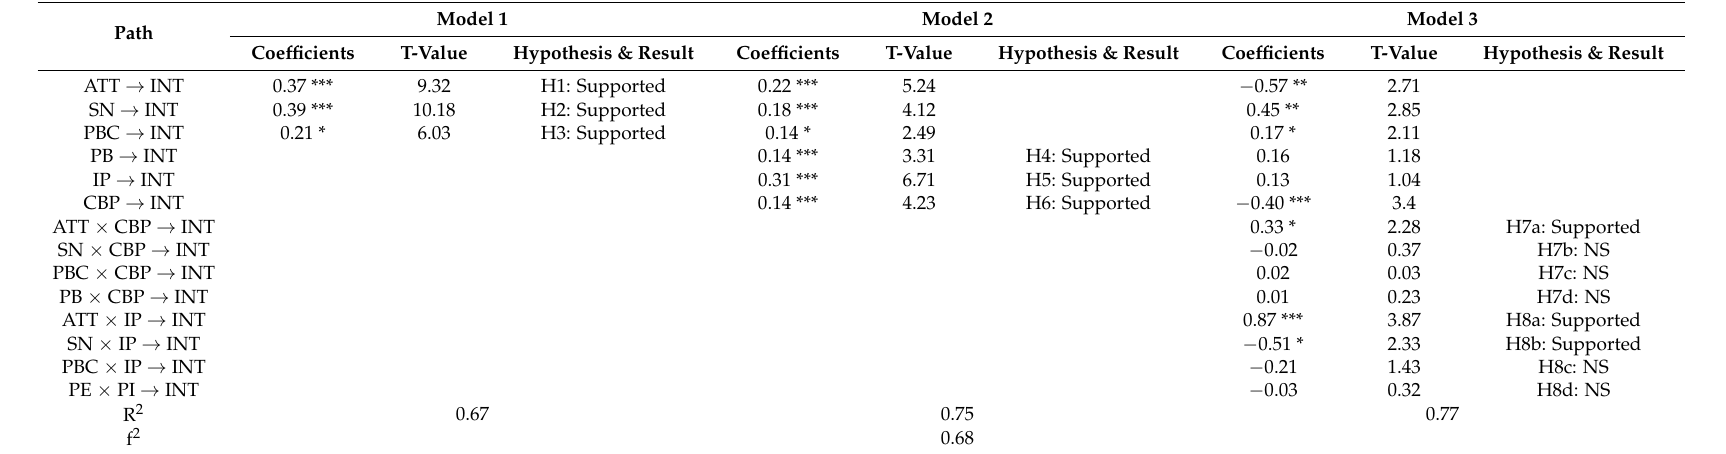
Table 5. Testing of the main and moderating effects of RRSW separation